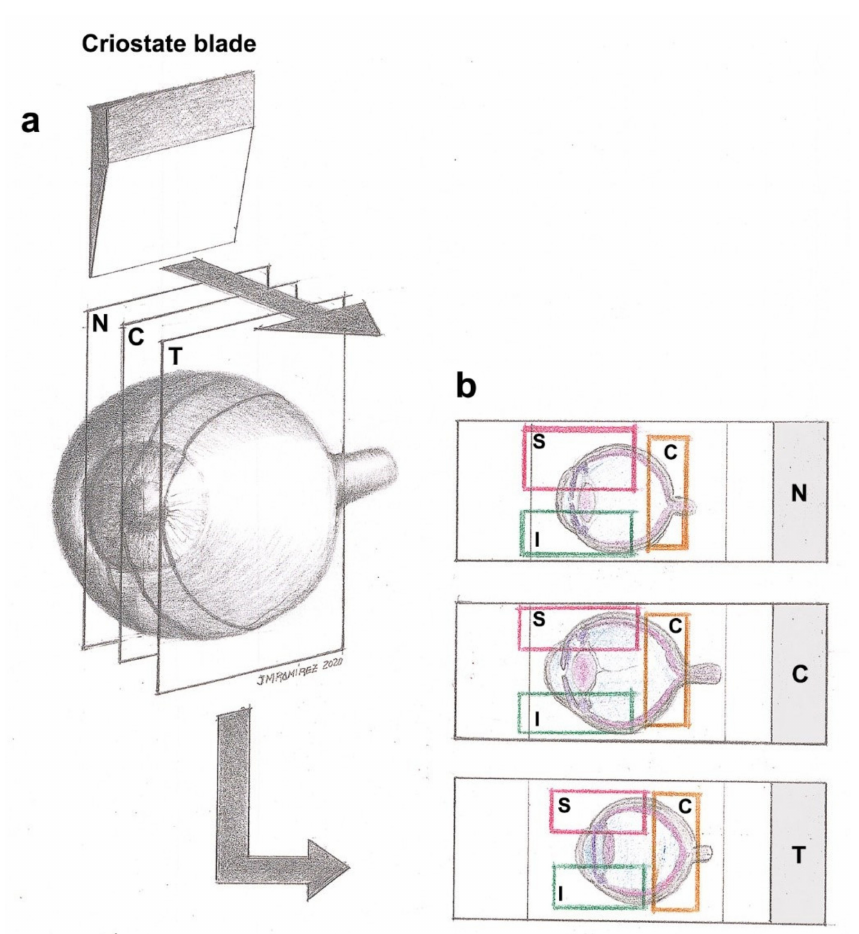
Figure 14. Diagram of the retina showing the nine spatial areas analyzed. ( a ) Each optical cup with the retina was frozen sectioned in 16 µ m-thick serial sagittal sections from nasal to temporal (nasal, central, and temporal) retina. ( b ) Tissue sections were collected onto gelatin-coated slides. Images were obtained at 20 × magnification from each region (nasal, central, and temporal) and zone of the retina (superior, central, and inferior), and equivalent areas of the retina were consistently selected in all slices (rectangle in ( b )). Immunostaining batches contained sections from the nine spatial areas indicated: nasal-superior, nasal-central, and nasal-inferior; central-superior, central-central, and central-inferior; and temporal-superior, temporal-central, and temporal-inferior. Abbreviations: N (nasal); T (temporal); C (central); S (superior); I